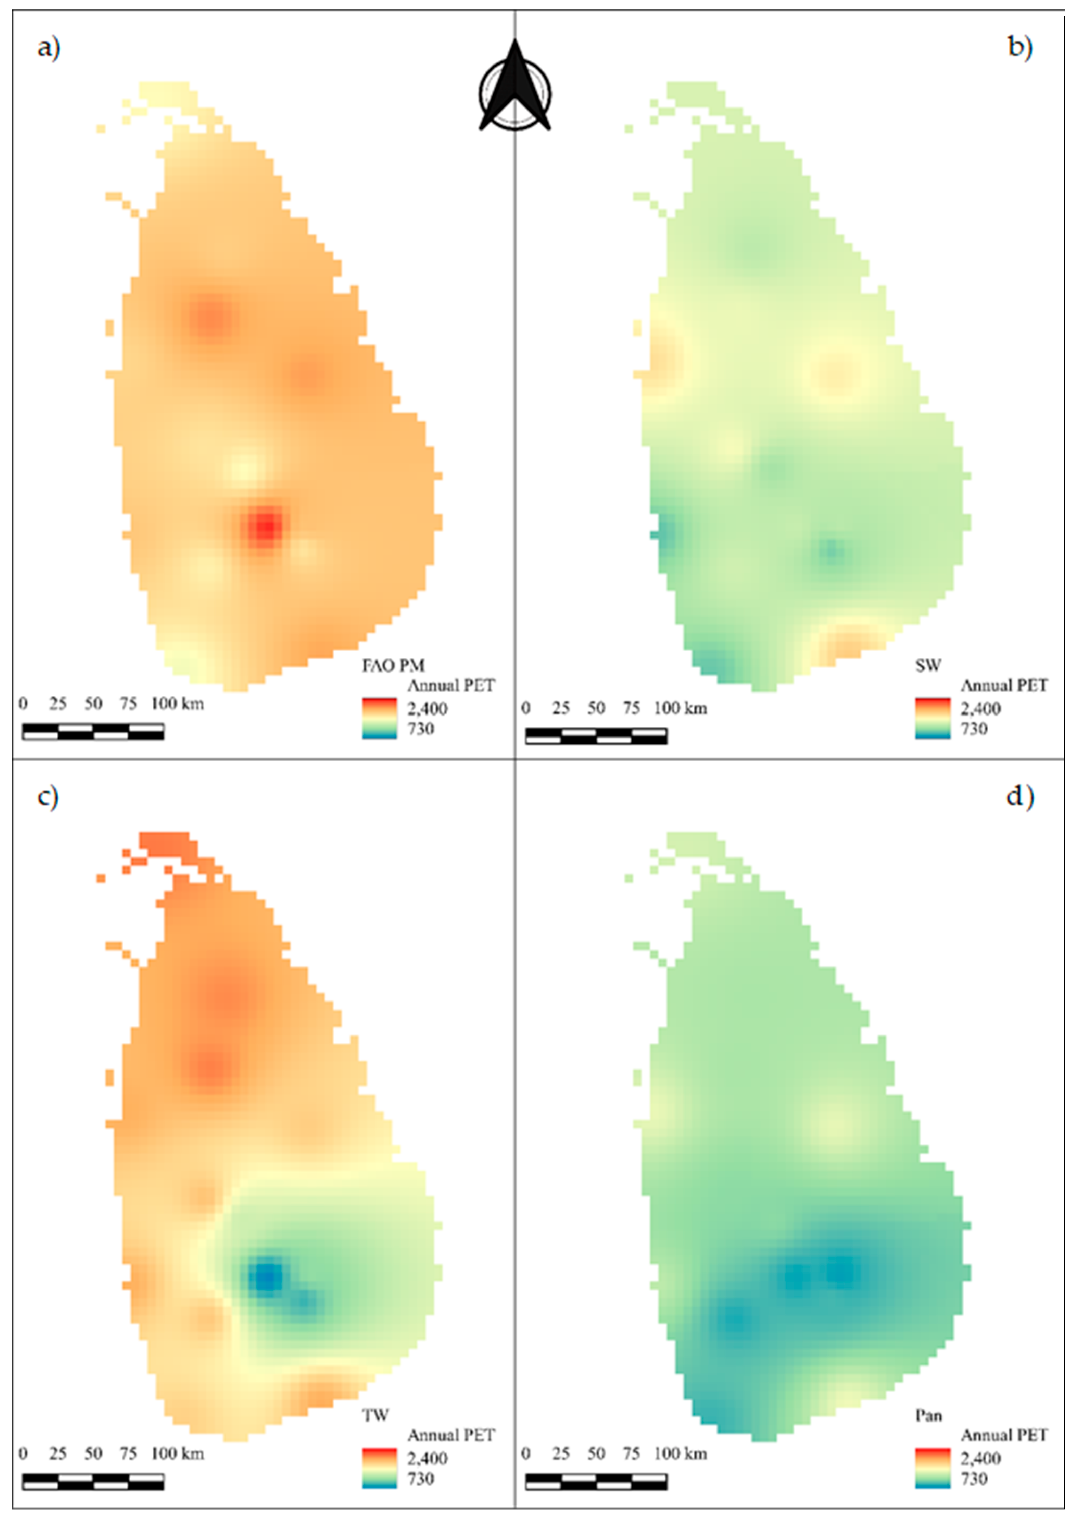
Figure 4. Spatial distribution of annual PET generated by: ( a ) FAO P–M method; ( b ) S–W method; ( c ) TW method and ( d ) pan